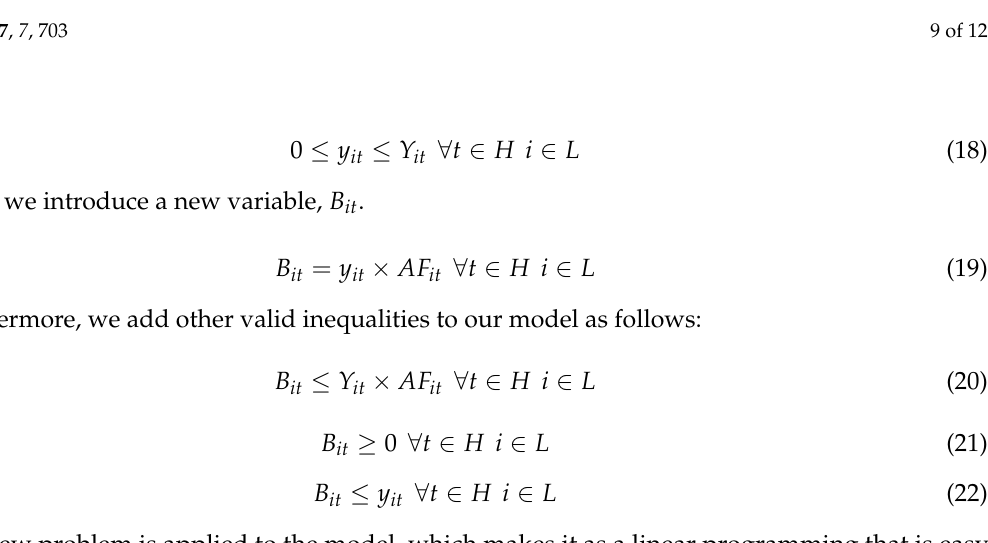
Table 6. Distribution plan with the subcontracting strategy using the maximal capacity.